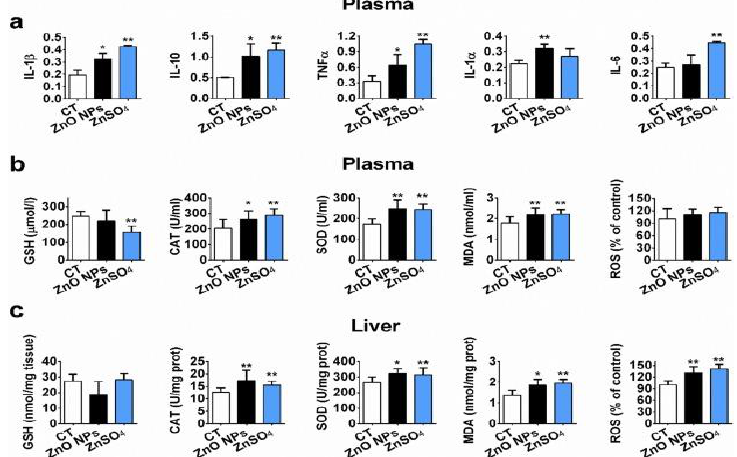
Figure 39. Toxicity of ZnO NPs and ZnSO 4 to Sprague-Dawley rats via intranasal exposure. ( a ) The induction of inflammatory cytokines in plasma, ( b ) elevated ROS, MDA, CAT and SOD activities in plasma, and ( c ) overexpression of ROS, MDA, CAT and SOD levels in liver. Data are expressed as mean ± SD (n = 10). CT indicates control group without ZnO NPs or ZnSO 4 treatment. * p < 0.05 and ** p < 0.01 imply significant difference compared with CT. Reproduced from [183] under the Creative Commons Attribution license.